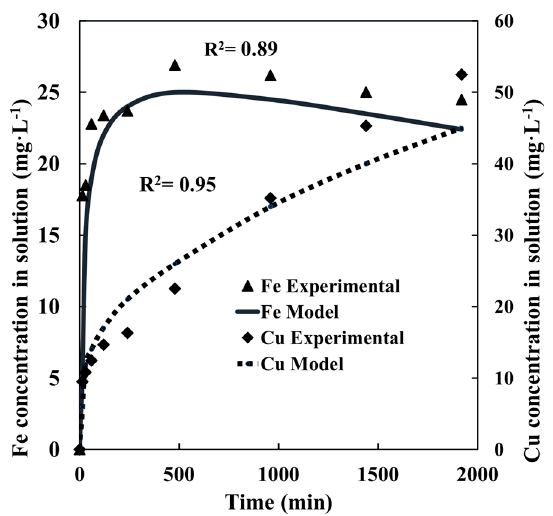
Figure 7. Iron and copper concentrations in solution for the gold + pyrite + chalcopyrite leaching system.